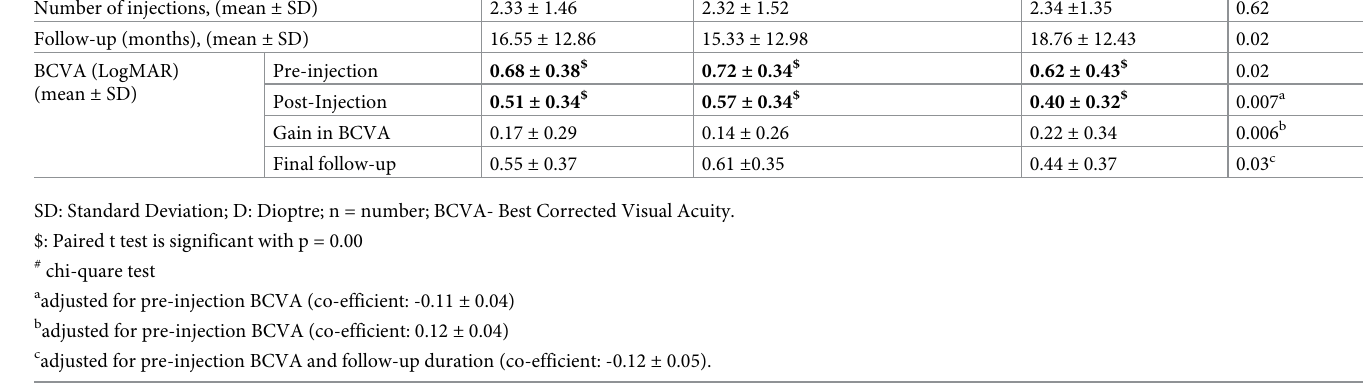
Table 3. Shows the baseline characteristics and visual outcomes in the overall, bevacizumab and ranibizumab group.